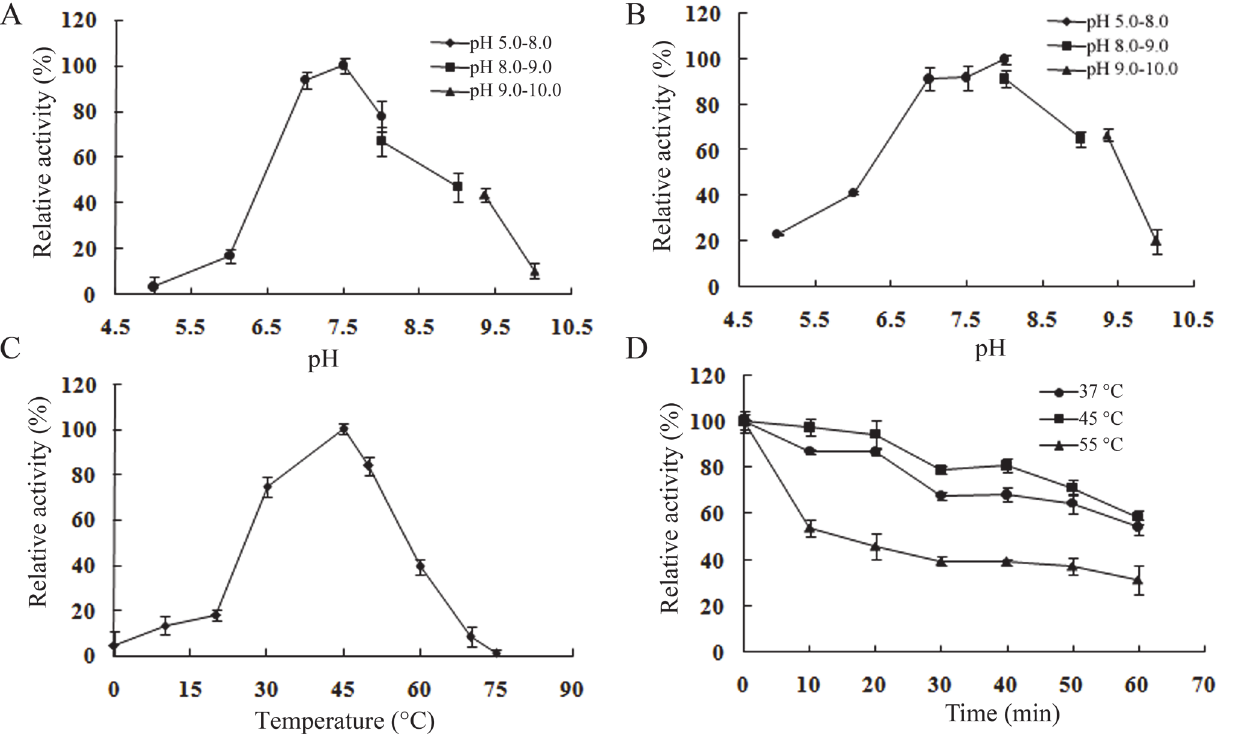
Fig 4. Effect of temperature and pH on CarEW activity and stability. Relative activity of purified CarEW was determined at different temperatures (A) or pH (C) using ρ -NP butyrate ( ρ -NPC 4 ) as the substrate at 405 nm. Remaining enzyme activity was measured at 45°C and pH 7.5 after incubating purified CarEW at different temperatures (B) or pH for 60 min. Error bars represent the mean ± standard deviation ( n = 3).